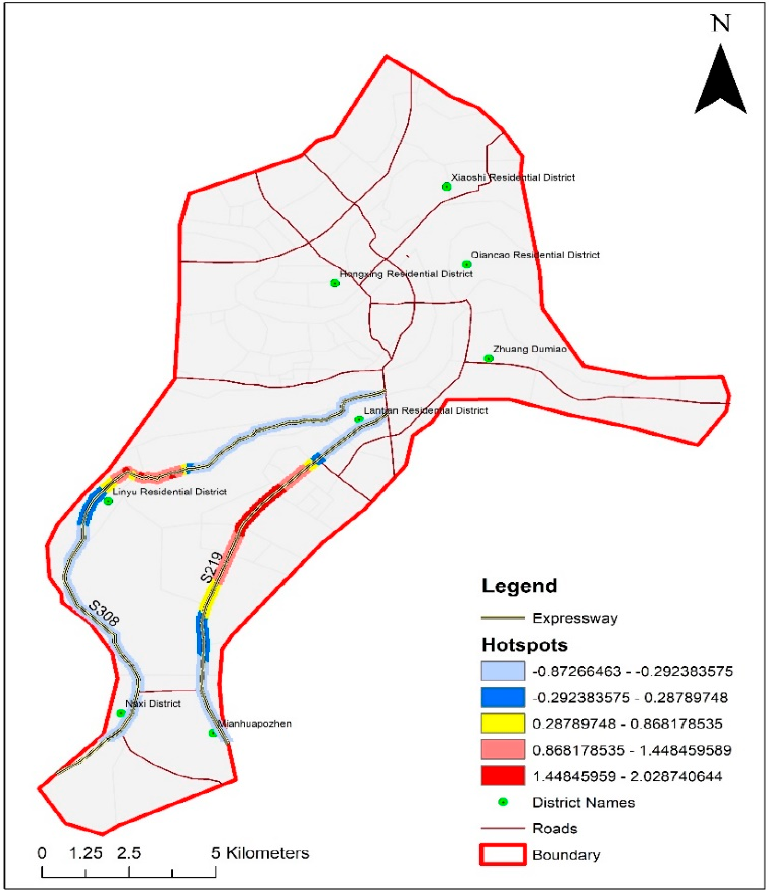
Figure 2. Violation hotspots mapping in the study area